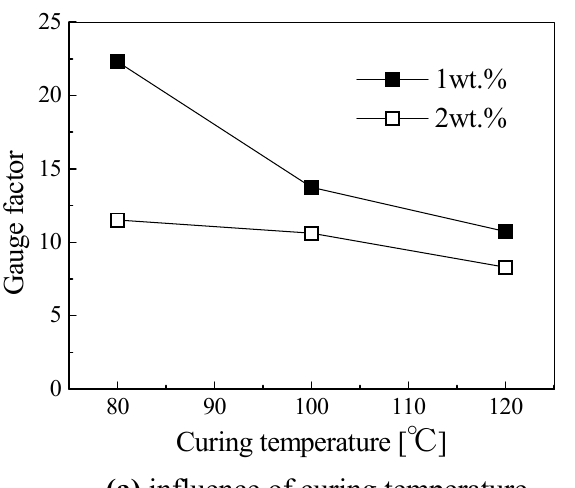
Figure 12. Influences of mixing speed and curing temperature on sensor